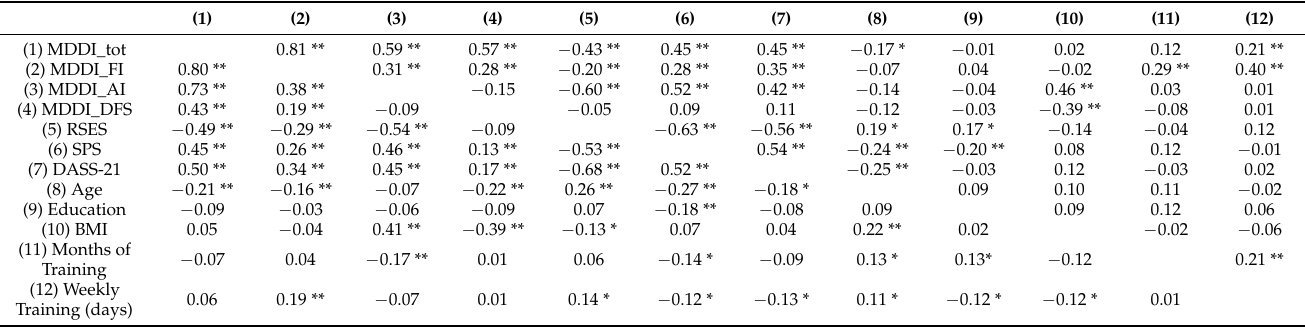
Table 4. Correlations between MDDI, scores on other measures included in the study, age, education, BMI, starting date of exercise, and weekly training in the non-competing bodybuilding/powerlifting subsample (top diagonal) and in the physical exercise subsample (bottom